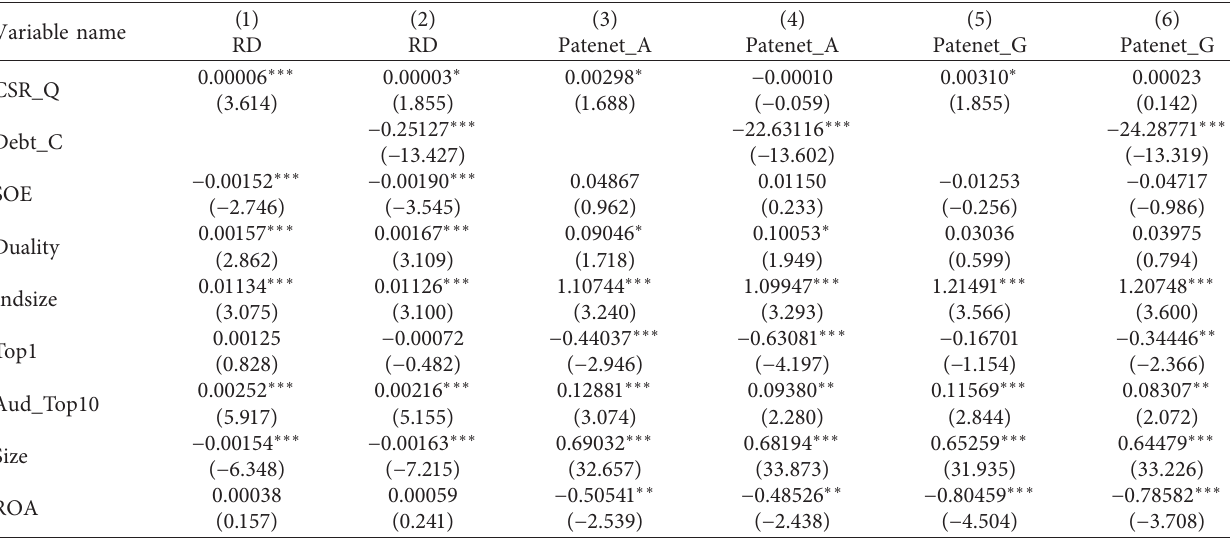
Table 12: Corporate social responsibility disclosure, cost of debt financing, and innovation capacity